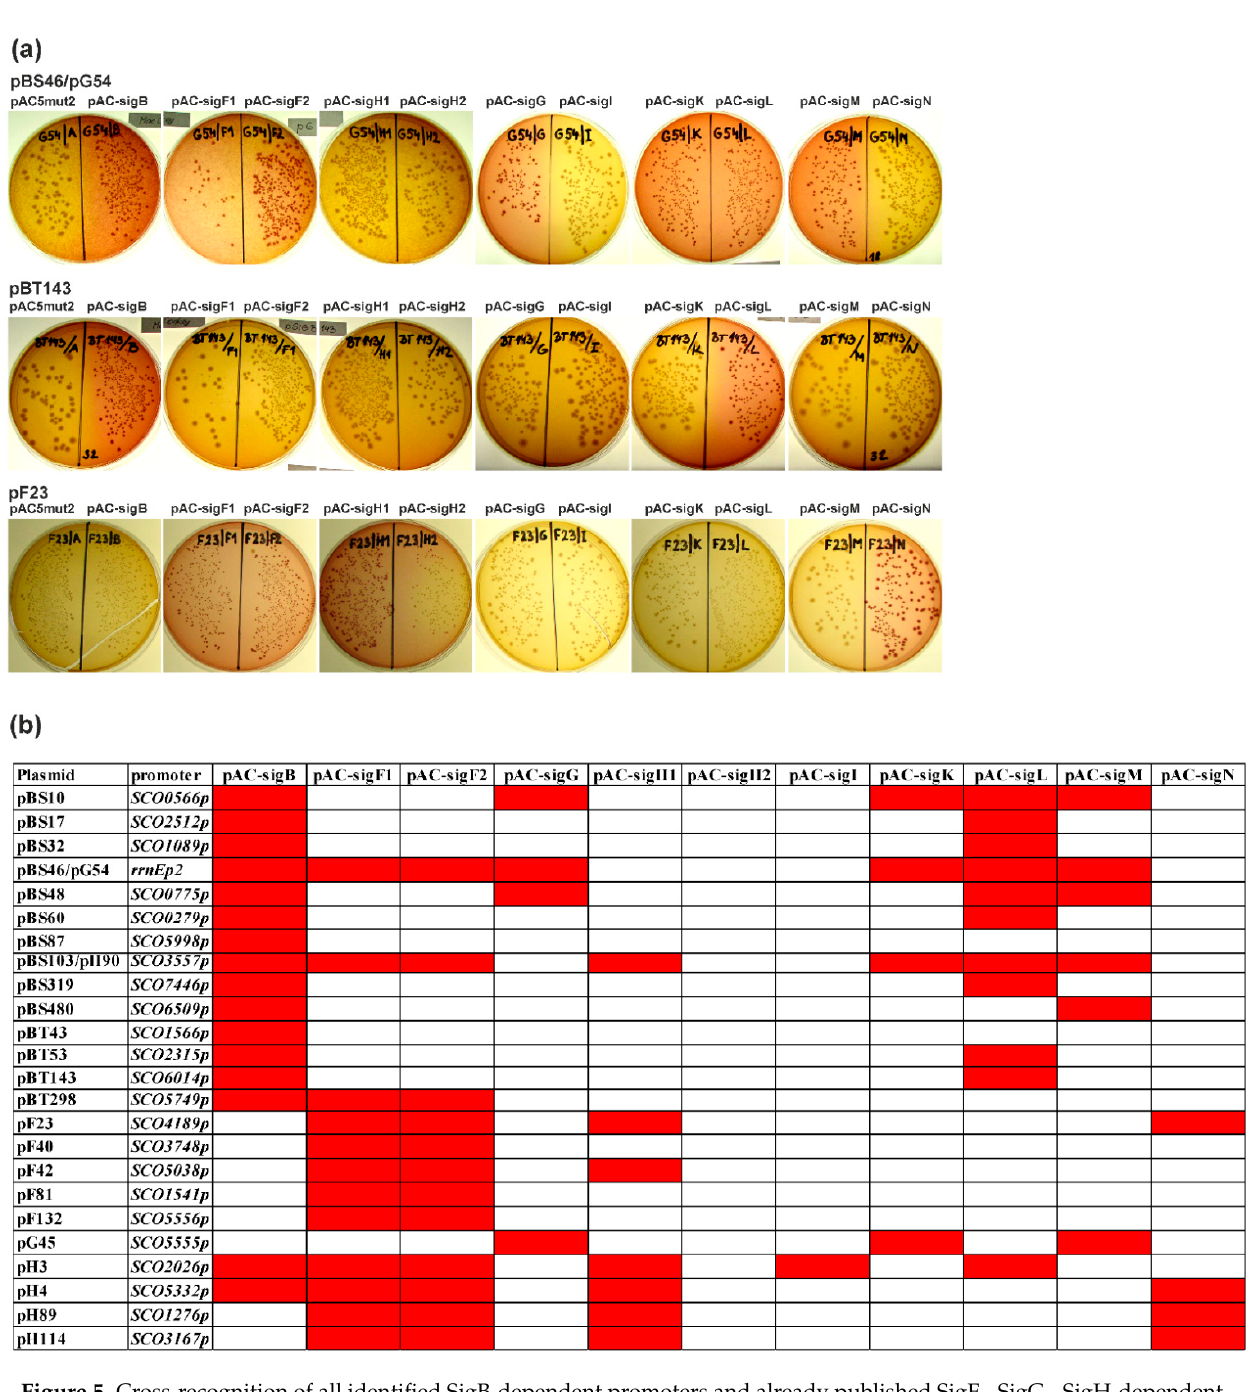
Figure 5. Cross-recognition of all identified SigB-dependent promoters and already published SigF-, SigG-, SigH-dependent promoters [20,36–39] with all nine SigB homologous sigma factors from S. coelicolor A3(2) with the E. coli two-plasmid system. ( a ) Examples of MacConkey agar plates (with Amp, Cm) with transformation mixtures of three plasmids containing sigma factor-dependent promoters (pBS46/pG54, pBT143, pF23) with combinations of expression plasmid pAC5mut2 and the vector with cloned sigma factor genes under the control of the trc promoter (pAC-). Red colonies correspond to